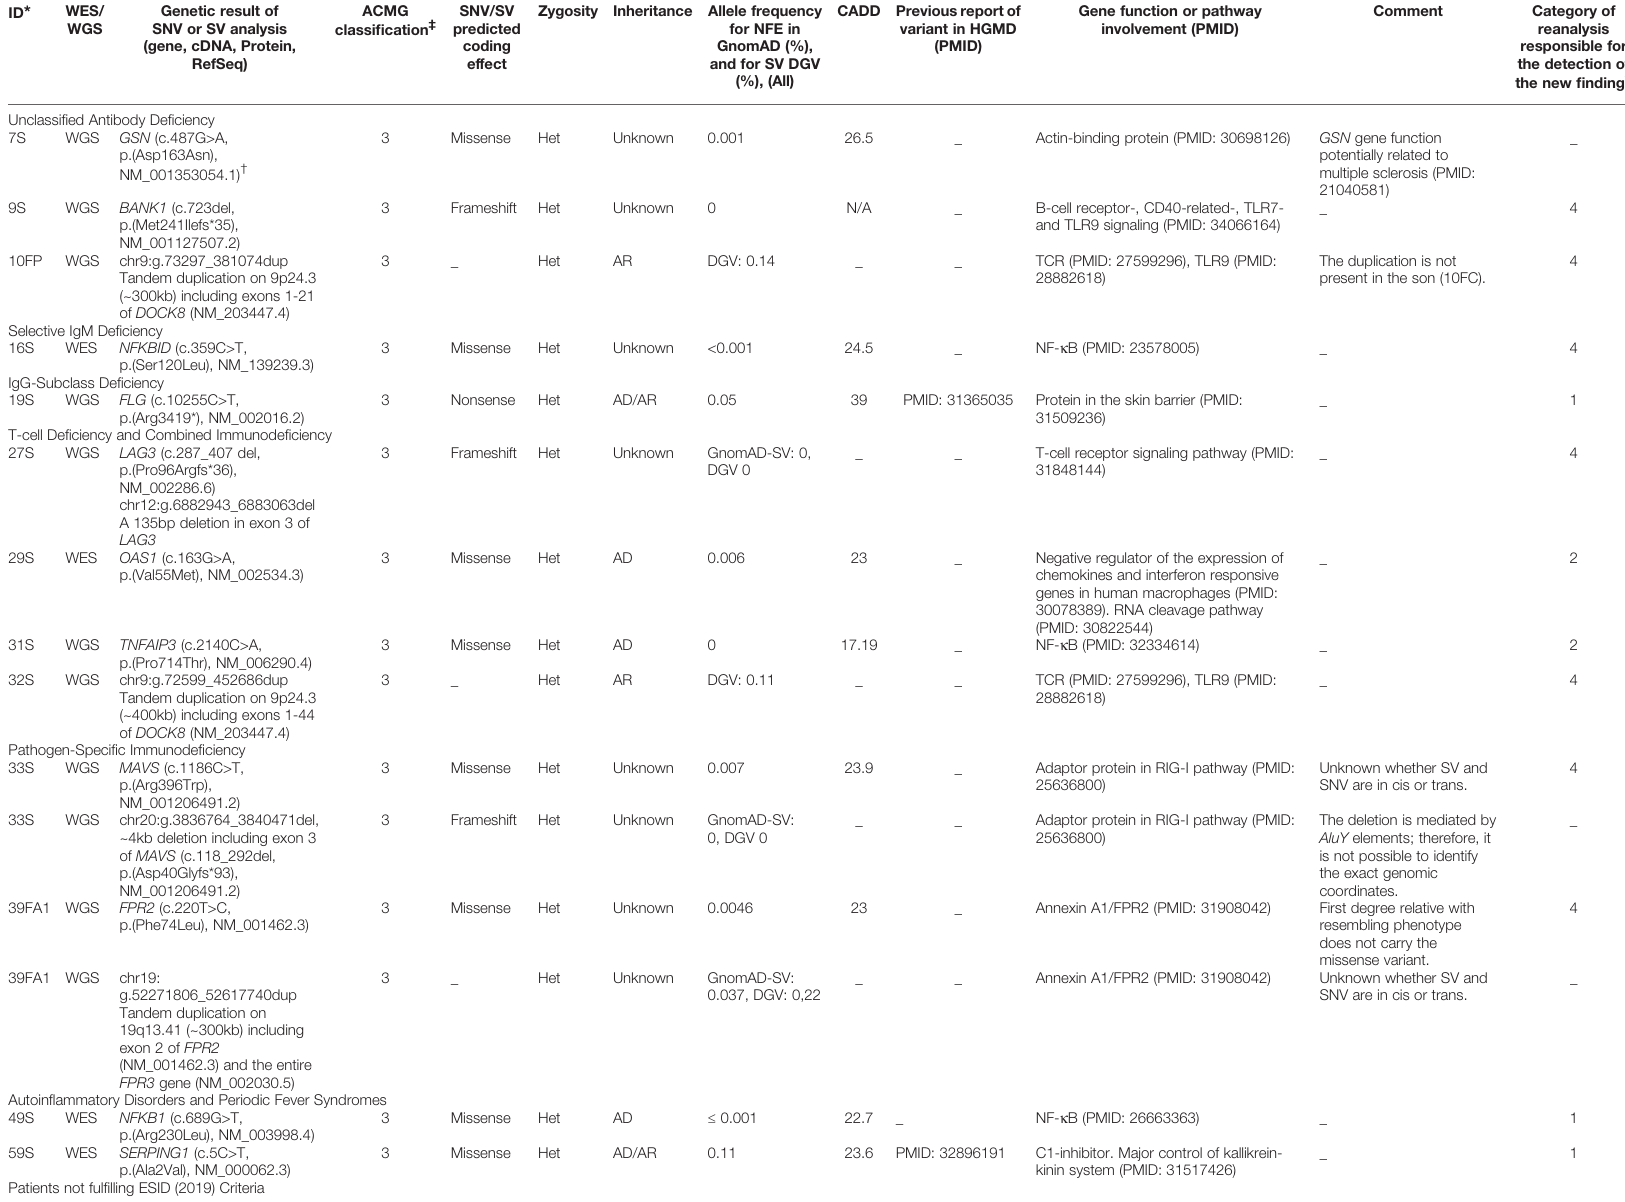
TABLE 2 | Variants detected after reanalysis with PID-2 and analysis for structural variation.